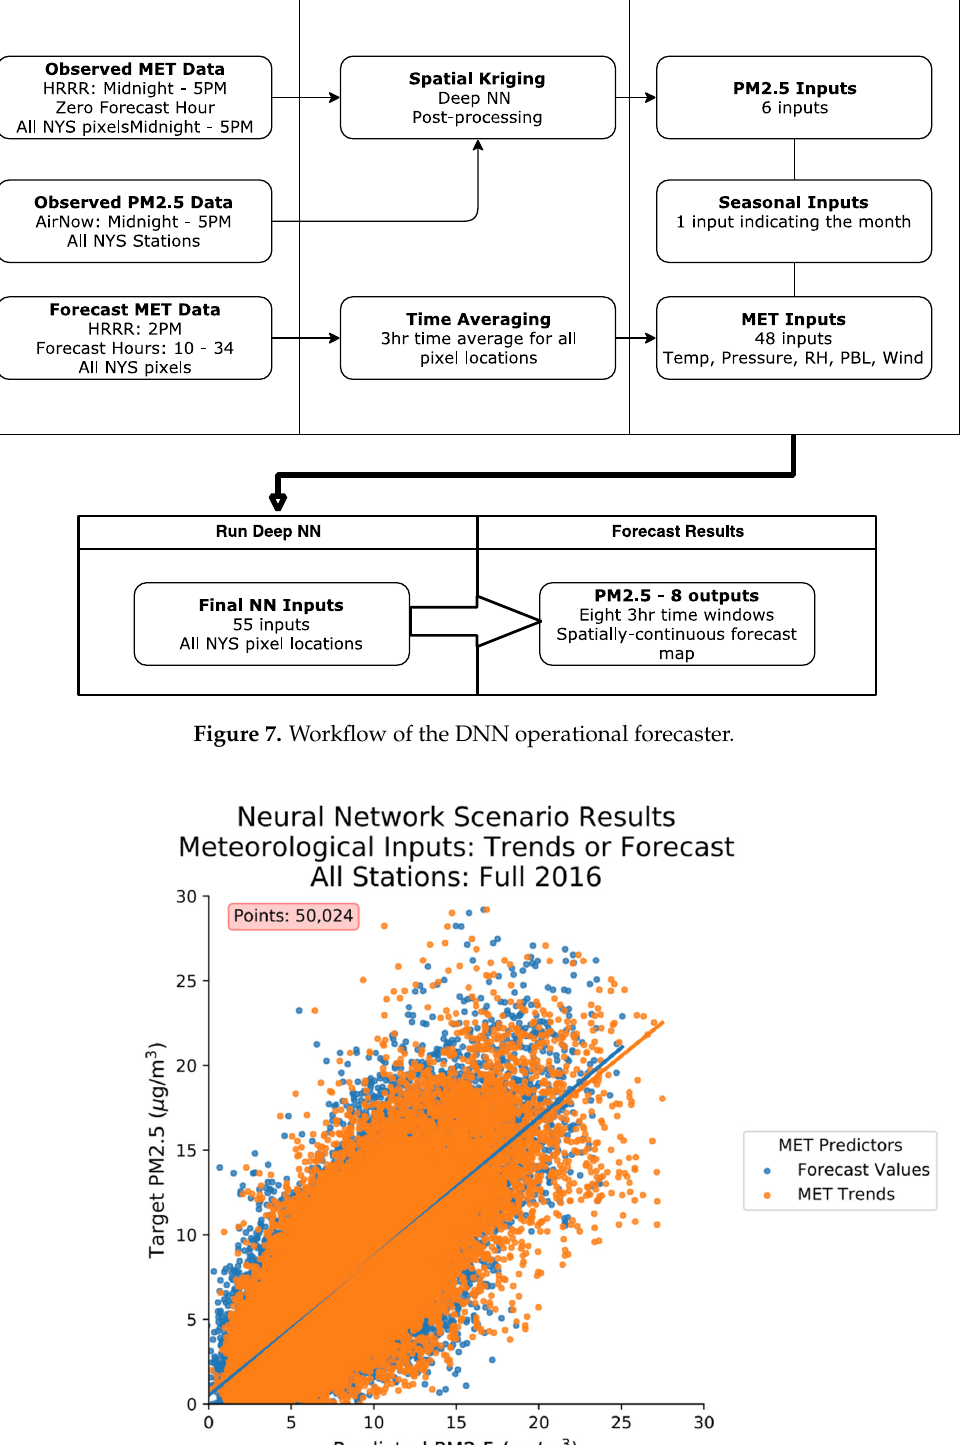
Table 3. Table of forecasting scores for all models tested.